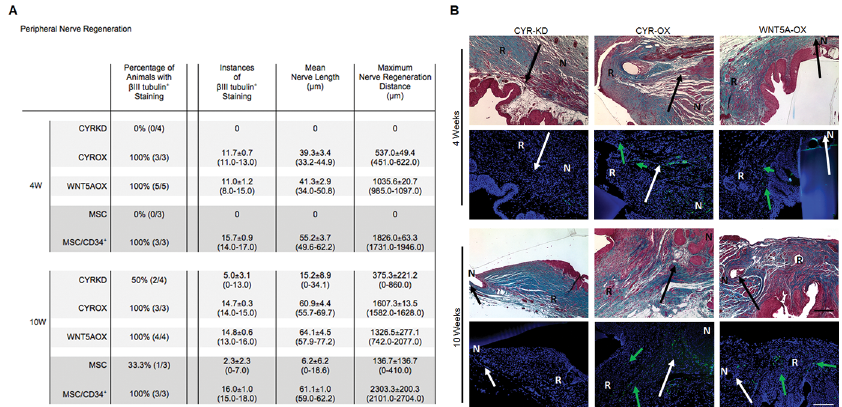
Fig 3. Effects of Cyr61 and Wnt5a on peripheral nerve regeneration. (A) Cyr61KD and MSC demonstrate no nerve regeneration at 4 weeks and poor nerve regeneration at 10 weeks. Wnt5aOX and MSC/CD34 + HSPC demonstrate increased early and robust nerve regeneration. Cyr61OX demonstrates nerve regeneration that continues to improve from 4 to 10 weeks. Data shown as means ± SEM (range). MSC and MSC/CD34 + HSPC data represent new quantitative assessment for a subset of samples from a previous study.[7] (B) Sample photomicrographs demonstrate β III tubulin (+) (green) neuronal staining (rows 2 and 4, blue: DAPI, green arrows: regenerated nerves, white arrows: transition between native and regenerated tissue, R: regenerated tissue, N: native tissue). Masson ’ s trichrome-stained images are of a serial section of tissue for each sample (rows 1 and 3; black arrows: transition between native and regenerated tissue). Scale bar, 200 μ m. (Unseeded, MSC and MSC/CD34 + HSPC images shown in S2